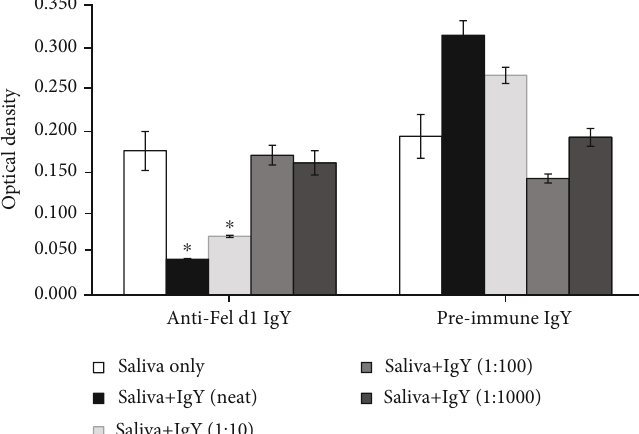
Figure 4: Chimeric ELISA evaluation of chicken egg anti-Fel d1 IgY antibodies on IgE binding compared to egg IgY antibodies from nonimmunized chickens. Anti-Fel d1 IgY antibodies dose-dependently inhibited binding to Fel d1-speci fi c IgE ( ∗ p < 0 : 001 ) while preimmune IgY had no inhibitory action. ∗ Signi fi cantly di ff erent from control ( p < 0 : 001